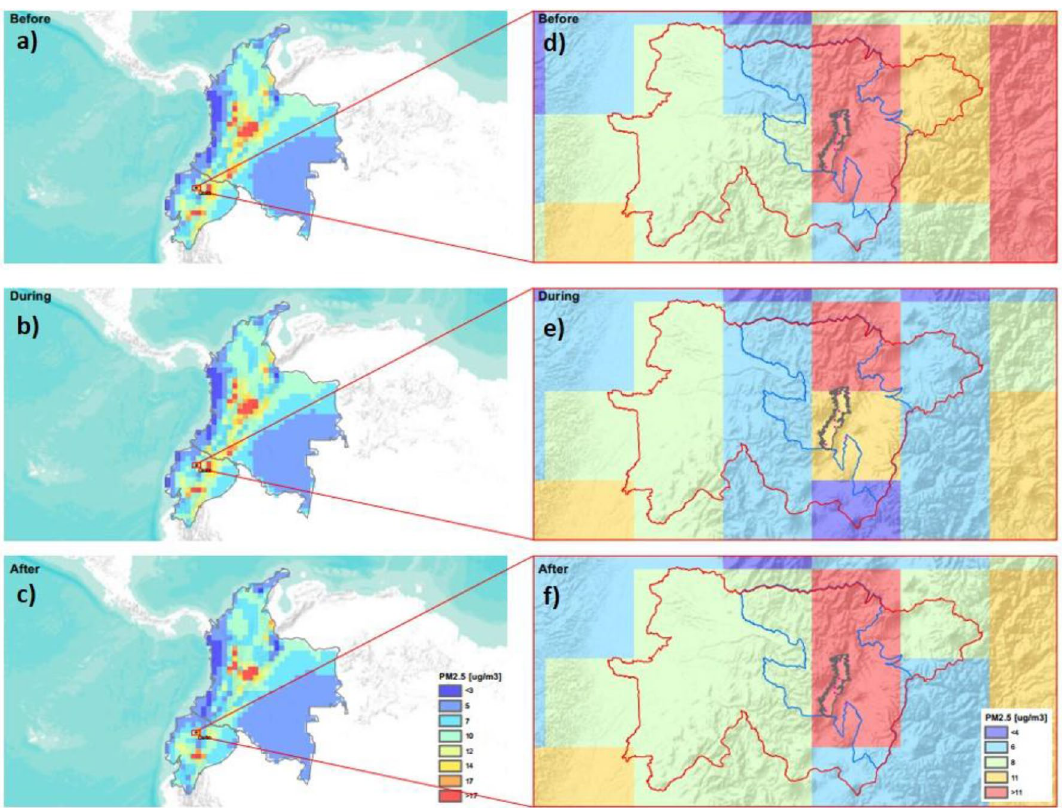
Figure 1. Satellite images of PM 2.5 concentrations for Ecuador and Colombia (panels a – c ) and the Pichincha region (red line) of Ecuador, containing Metropolitan District of Quito (blue line), and Quito city (grey line) (panels d – f ) averaged over 12 days of three periods: September 25–October 1 (before the strike, panels a and d ), October 2–13 (during the strike, panels b and e ) and October 14–25 (after the strike, panels c and f ). For the visualization of the ECMWF raster of PM 2.5 the ArcGis PRO software was used, with a resolution of 44 km / pixel, with a WGS84 projection system with ESPG 4326 coordinate system , these data are available at https:// devel opers. google. com/ earth- engine/ datas ets/ catal og/ ECMWF_ CAMS_ NRT? hl= en.